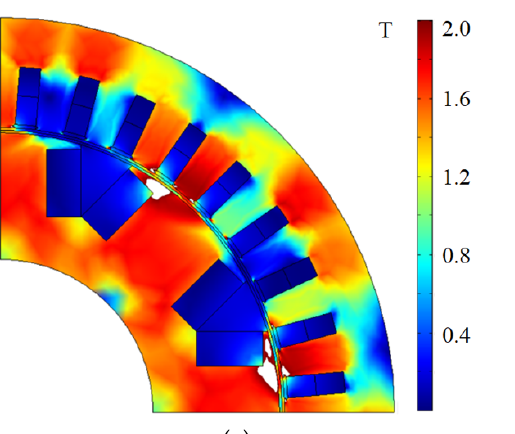
Figure 6. The cross-section of the initial design of the wound rotor synchronous motor and the magnitude plot of flux density; white areas mark the extreme saturation level (>2 T): ( a ) loading point 3; ( b ) loading point 1.